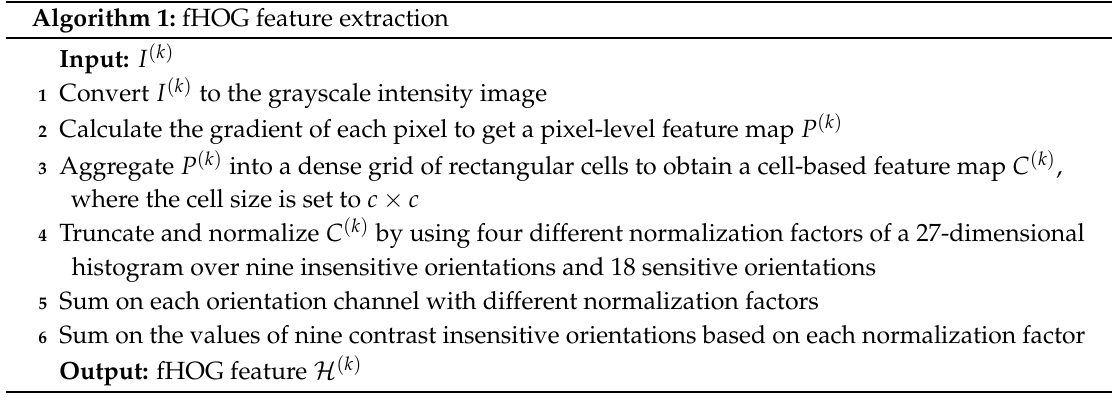
Algorithm 1: fHOG feature extraction